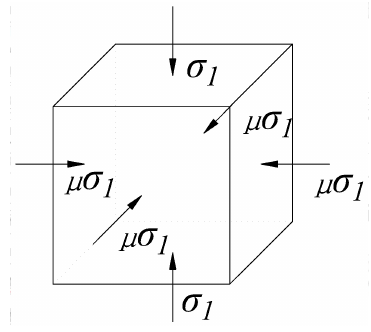
Figure 12. Schematic diagram of the stress in the